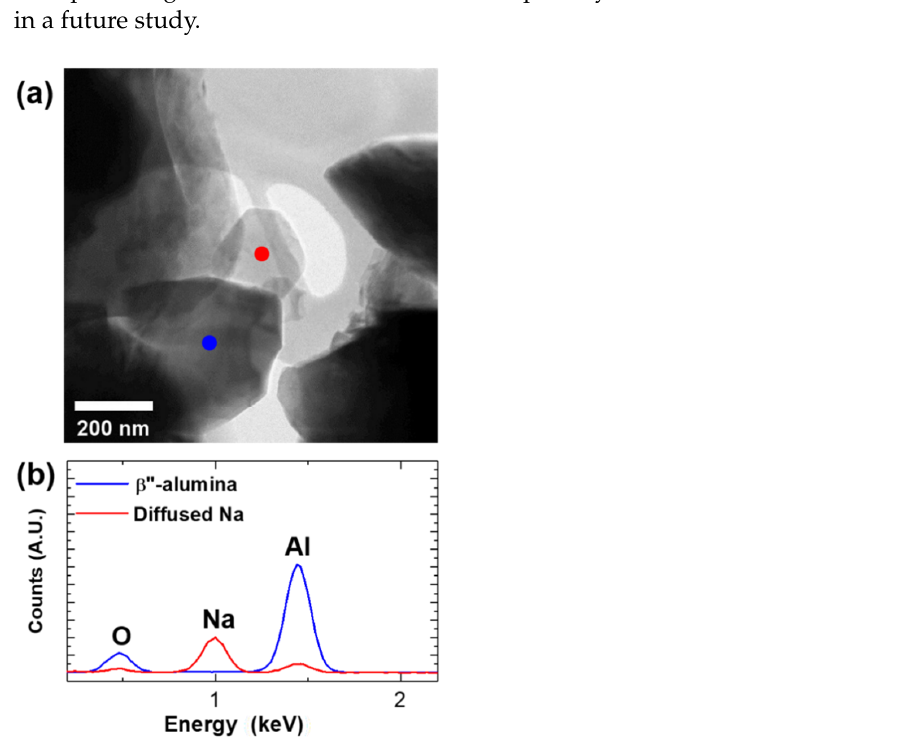
Figure 5. ( a ) Low-magnification BF-TEM image showing Na extraction from the Na-β″-alumina by electron beam illumination, ( b ) energy-dispersive spectroscopy (EDS) results obtained from the β″-alumina (blue dot) and extracted Na (red dot).